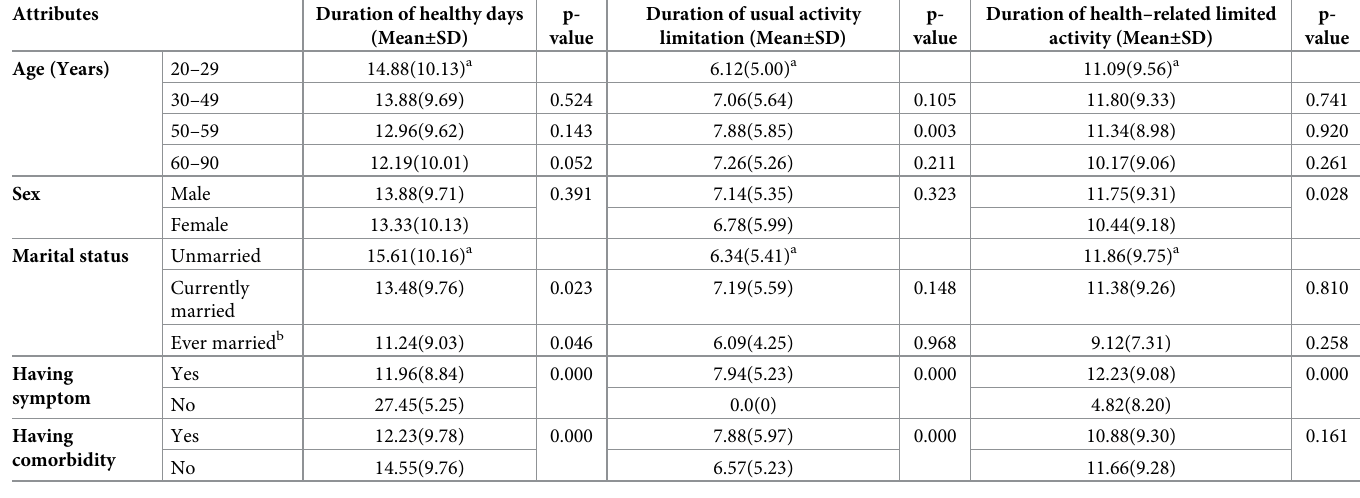
Table 4. Mean ± SD duration of selected items of HRQOL by background and clinical attributes of the COVID-9 patients (n = 1204).